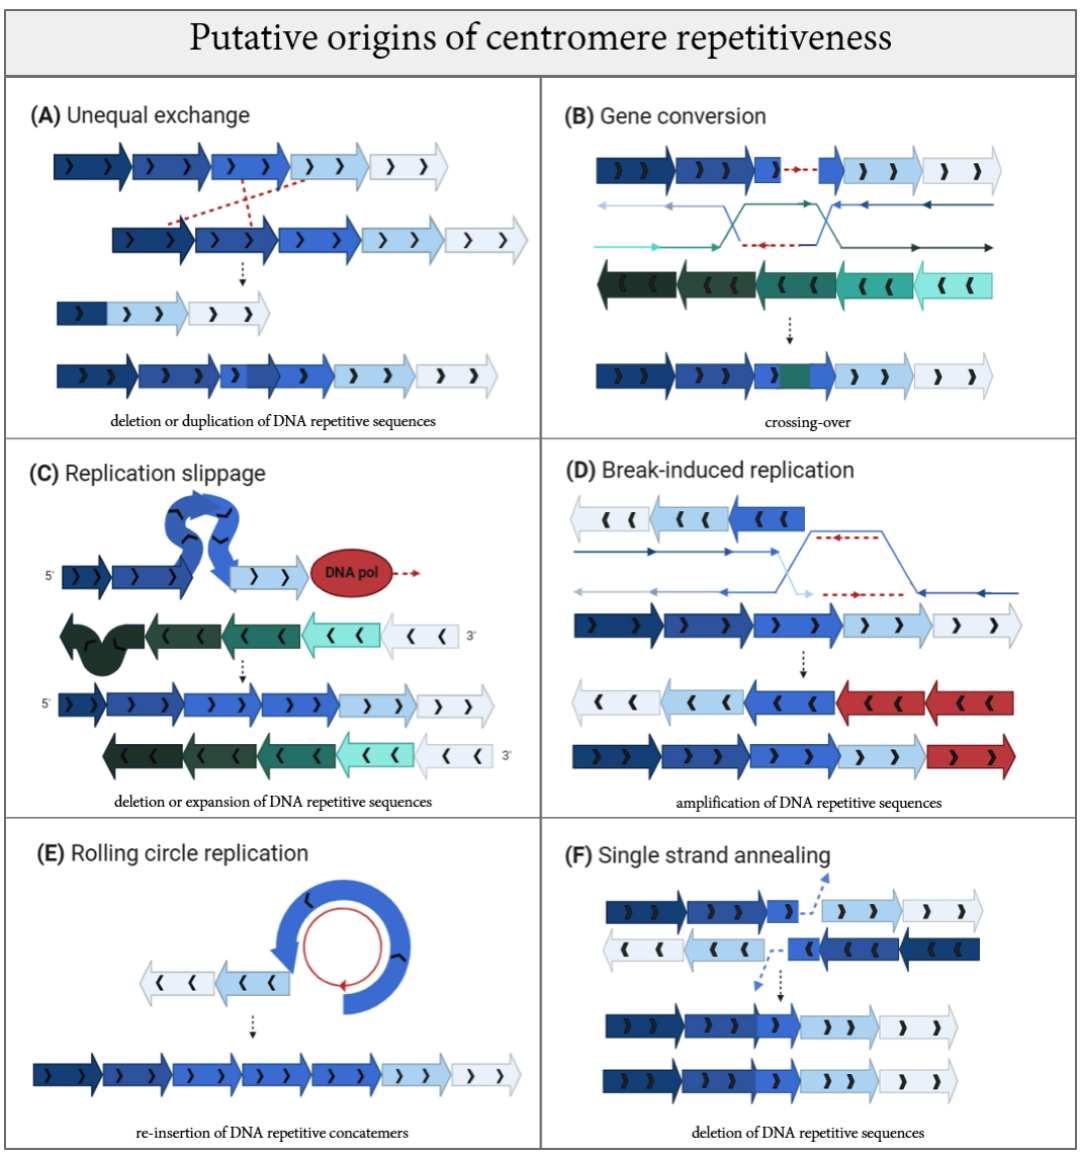
Figure 3. Mutagenic processes that may operate at centromere sequences and have contributed to their repetitive origins. ( A ) Unequal exchange following recombination can cause gain or loss of tandem repeats and DNA rearrangements. ( B ) Gene conversion causes the unidirectional transfer of genetic information among homologous repetitive DNA sequences and can result in reciprocal or non-reciprocal exchange (the latter is depicted). ( C ) Replication slippage on misalignment repeated DNA strands during replication is thought to induce centromere expansion or contraction depending on whether the hairpin (depicted)/distortion is found on the newly synthesized strand (blue repeats) or the bulge (depicted)/distortion is on the template DNA (green repeats). ( D ) Break-induced replication (BIR) repairs one-ended double-stranded break (DSB) substrate, produced by replication fork collapse. ( E ) Rolling circle replication occurs when the 3′ end circularizes, and its replication produces repeated concatemers. ( F ) Single strand annealing (SSA) repairs DSBs through the annealing of complementary ssDNA strands succeeded by DNA tail end digestion and ligation. These repair pathways are essential for maintaining genome stability, yet when operating on repetitive sequences (especially arranged in tandem and sharing high degree of sequence homology like at the centromere), they may result in mutagenic variability as a way for ongoing DNA evolution and shaping.